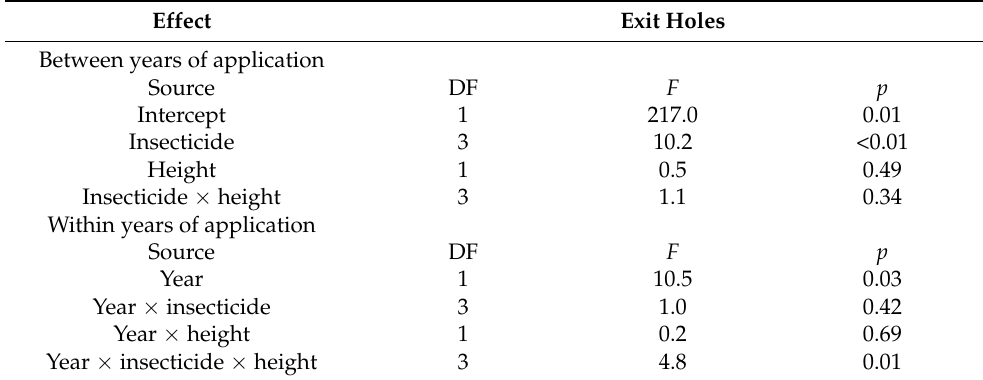
Table 2. MANOVA parameters for main effects and interactions for exit holes of Xylotrechus chinensis adults between and within years of application (error DF = 72).